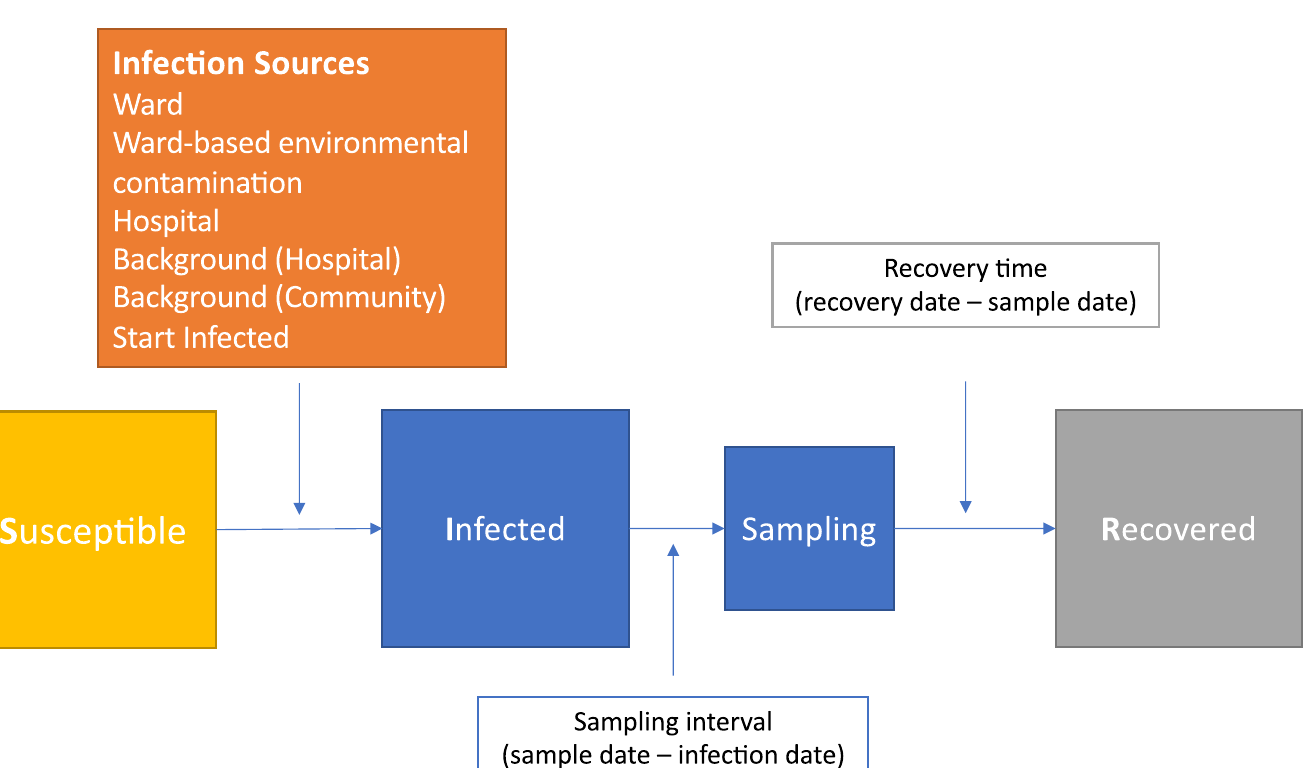
PLOS Computational Biology | https://doi.org/10.1371/journal.pcbi.1008417 January14,